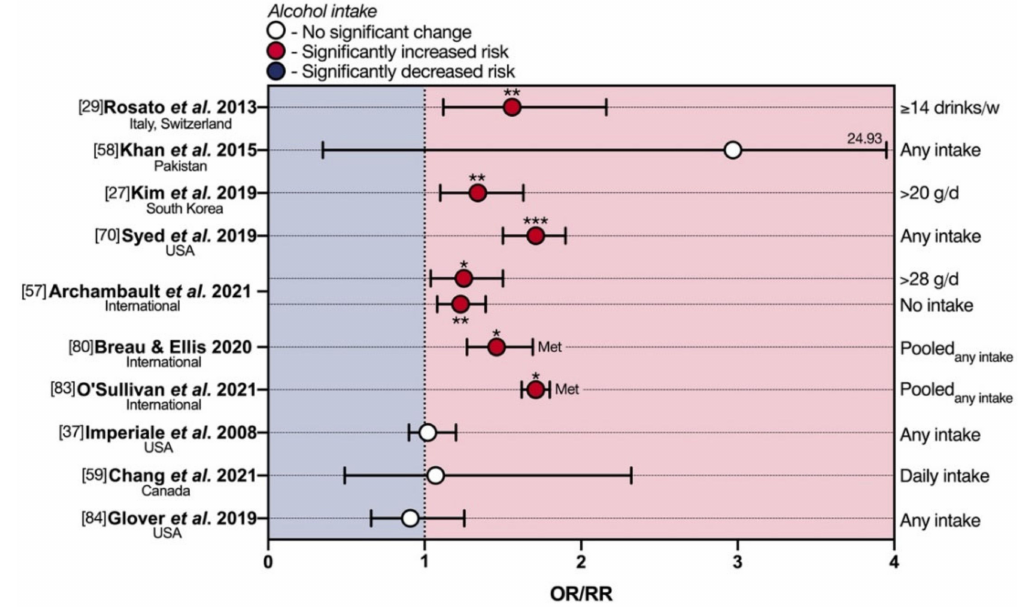
Figure 3. Deleterious effects of alcohol in early-onset colorectal cancer. eoCRC—early-onset colorectal cancer; Met—meta- analysis; OR—odds ratio; RR—relative risk. * p < 0.05; ** p < 0.01; *** p <